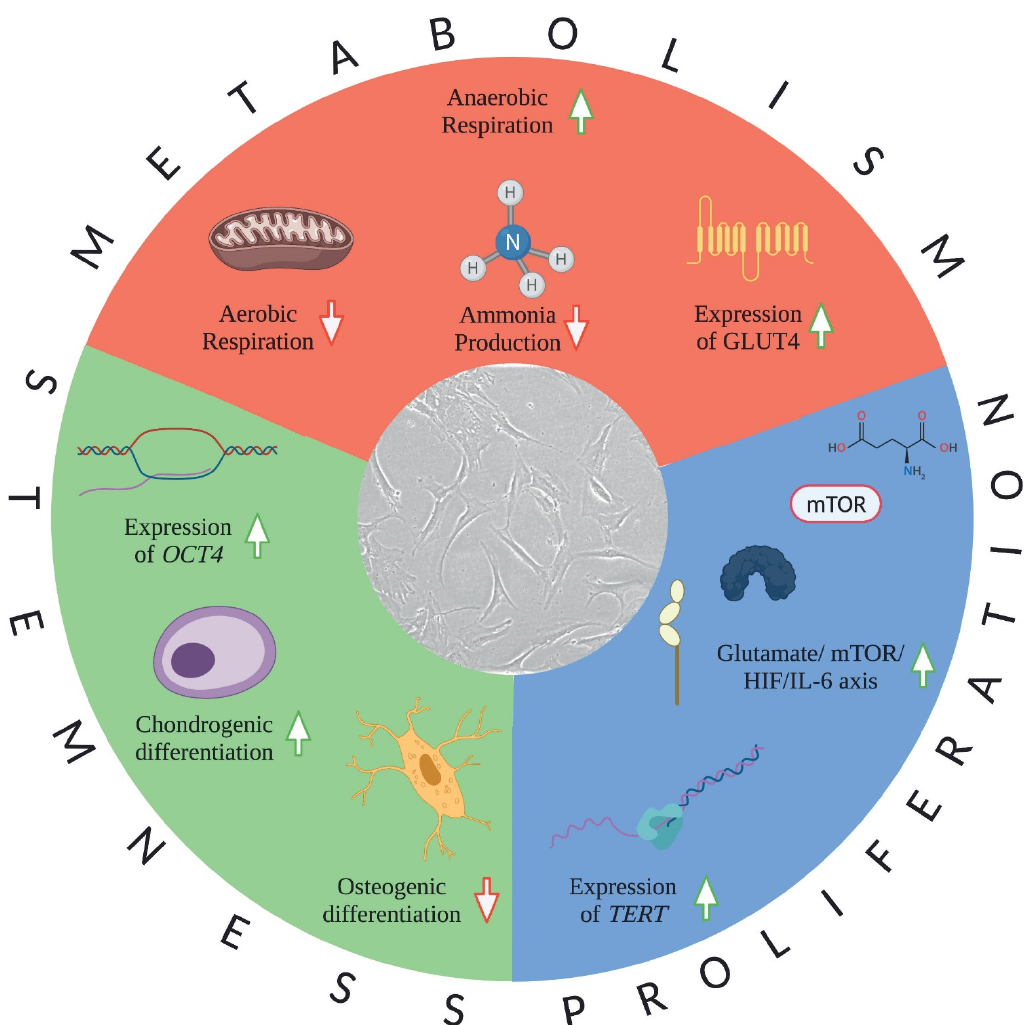
Figure 1. Adaptive measures of the bone marrow-derived stromal cells in hypoxic conditions. BMSC show complex adaptive measures under hypoxic conditions that affect practically all aspects of their physiology. Abbreviations used are: GLUT4: glucose transporter type 4; mTOR: mechanistic target of rapamycin; HIF: hypoxia inducible factor; IL-6: interleukin-6; TERT: telomerase reverse tran-scriptase; OCT4: octamer-binding protein 4. Micrograph of the human bone marrow- derived stomal cells are made by Zsolt Fabian. Figure was created using BioRender.com.